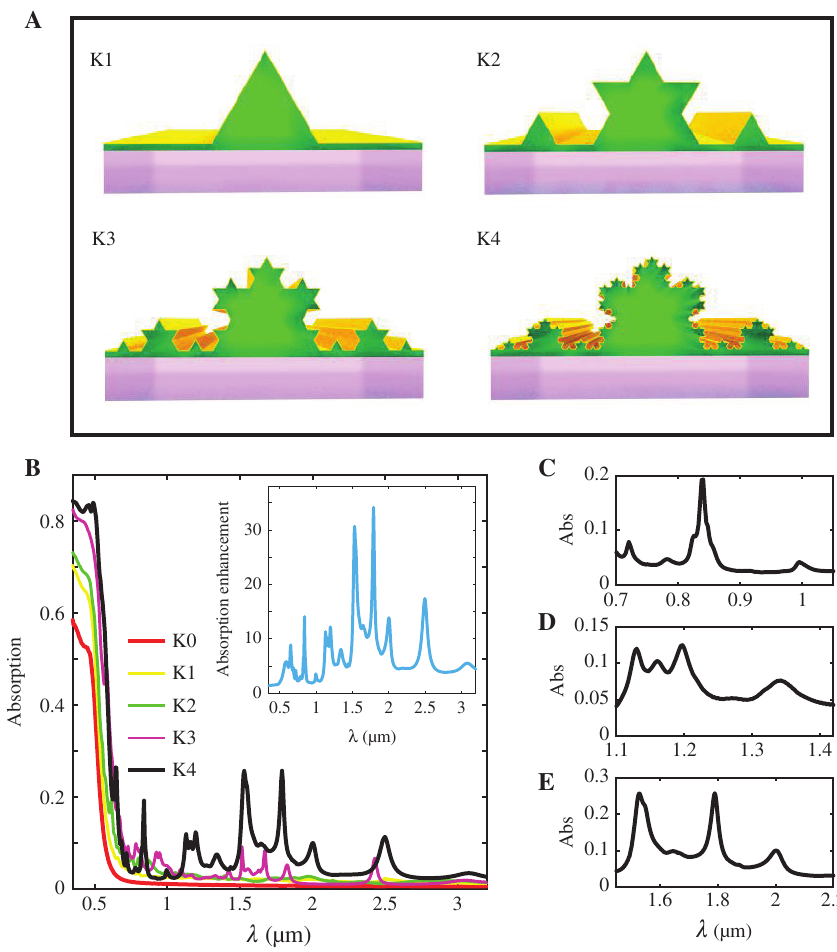
Figure 2: Enhanced absorption of the plasmonic leaf. (A) Schematic for the structures based on Koch curves with different fractal orders. (B) Absorption spectra of the structures with different fractal orders. The inset shows that the absorption was enhanced between K4 and K0. (C–E) Self-similarity in the absorption from K4. At different wavelength ranges, similar absorption spectra are observed as a result of the fractal to x = 0. For Koch curves, the perimeter is enlarged by a 4 as the fractal order increased by 1, which boosts factor of 3 the light-matter interaction area under the same light power, leading to the absorption improvement shown in Figure 3A. The absorption saturation is not observed at K4, owing to the comparable feature size (180 nm) with optical wavelength. The enhancement factor is not as large as the perimeter enlargement, as a strong interac- tion (with a large field amplitude) does not occur in all the area. Figure 3B compares the absorption power density: